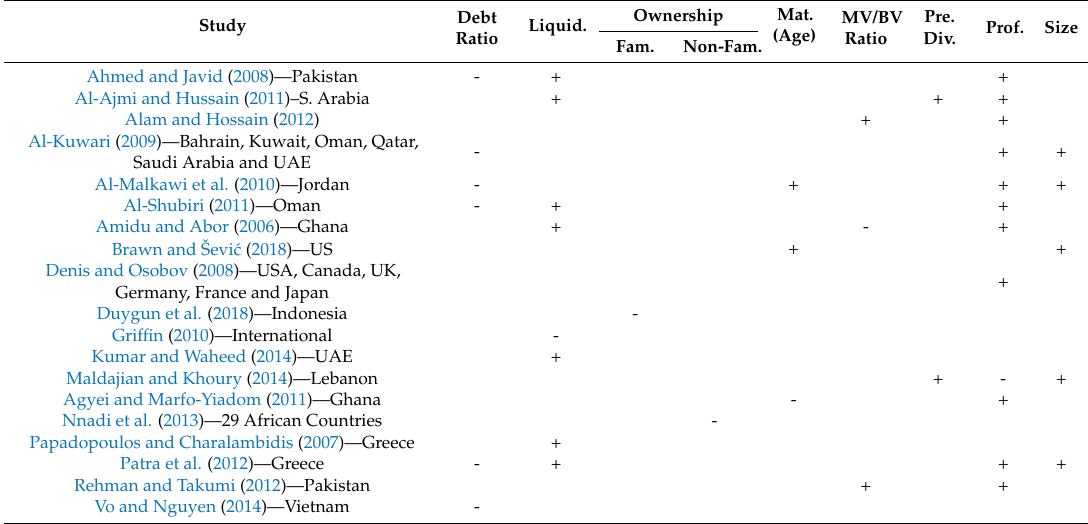
Table 1. Effect of Internal Factors on Dividend Payout (Empirical